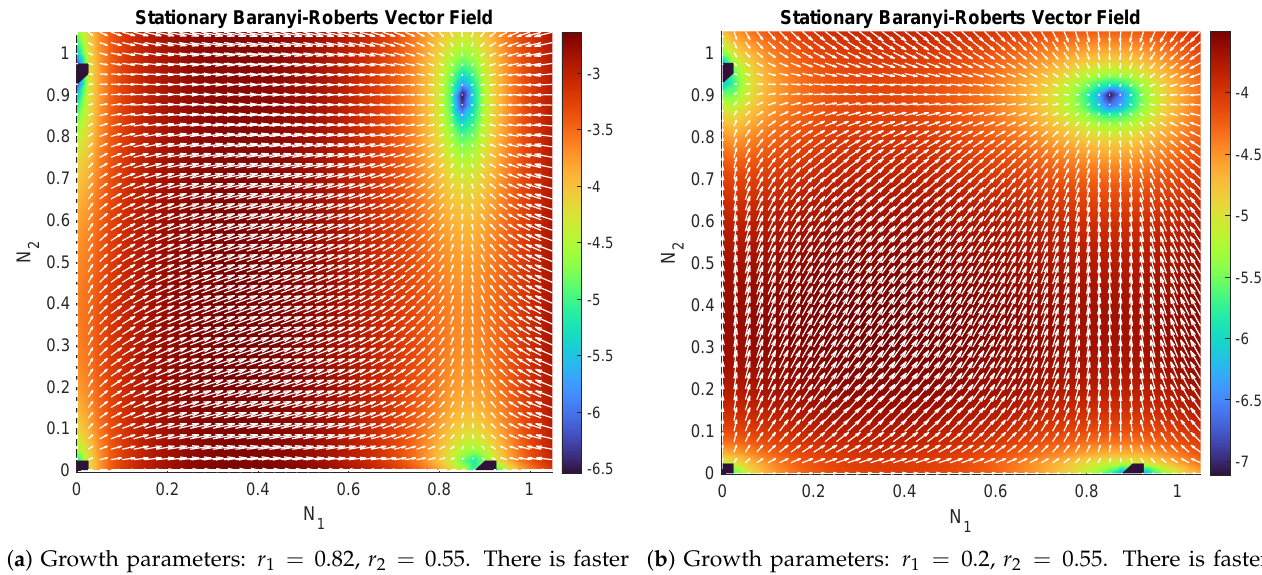
( a ) Growth parameters: r 1 = 0.82, r 2 = 0.55. There is faster ( b ) Growth parameters: r 1 = 0.2, r 2 = 0.55. There is faster growth for N 1 . Therefore, we can see a more horizontally- growth for N 2 . Therefore, we can see a more vertically-aligned aligned vector field. vector field. Figure 1. Comparison of the flow function g ( · ) and its log-magnitude, log ( (cid:107) g ( · ) (cid:107) 2 ) , given by the Baranyi–Roberts system (9) and (10) with the set of parameters described in each figure, and K 1 = 0.9, K 2 = 0.95, ν 1 = 0.3, ν 2 = 0.15, c 1 = 0.01, c 2 = 0.015 in both figures. In darker color, the four equilibrium points that are given by the solutions of the nonlinear system (11) and